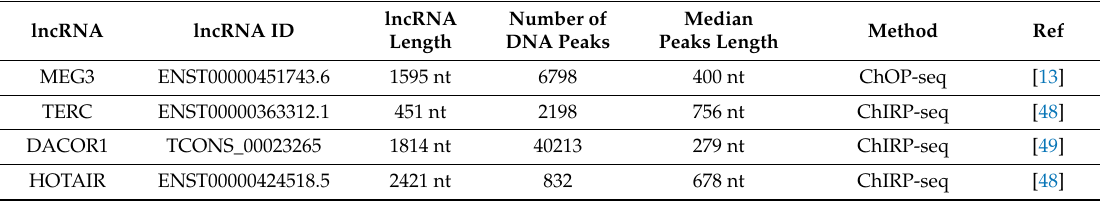
Table 2. Summary statistics and data sources for lncRNAs used in this